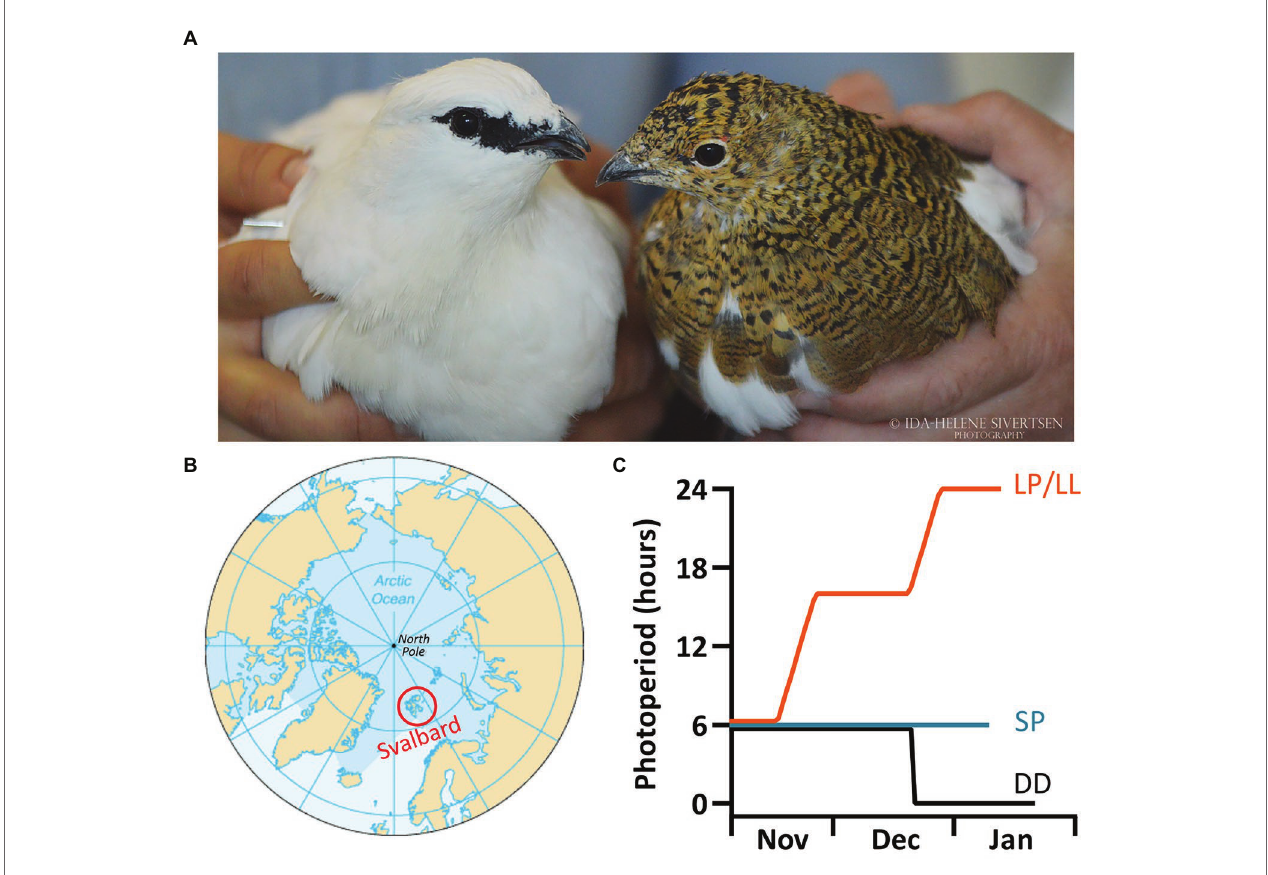
FIGURE 1 | Svalbard ptarmigan ( Lagopus muta hyperborea ) and experimental design. (A) The picture shows a Svalbard ptarmigan male in white winter plumage and a female in the cryptic brown summer plumage (© Ida-Helene Sivertsen). (B) The Svalbard ptarmigan is a subspecies of the rock ptarmigan ( Lagopus muta ) but is geographically isolated to the high Arctic archipelago of Svalbard and Franz Josef Land. (C) The experimental birds were bred at the University of Tromsø and were separated into three groups: the short photoperiod (SP) group remained under L:D 6:18. The LP/LL-group was gradually transferred from L:D 6:18 to L:D 16:8 (LP), and subsequently into constant light (LL). The constant darkness (DD) group was directly transferred from L:D 6:18 into